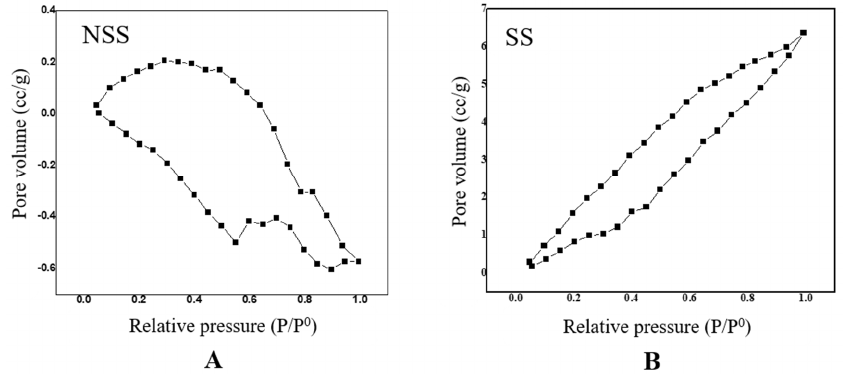
Figure 3. BET surface analysis (N2-adsorption–desorption) of G. superba seeds ( A ) Non scarified seed (NSS), ( B ) Scarified seed (SS).